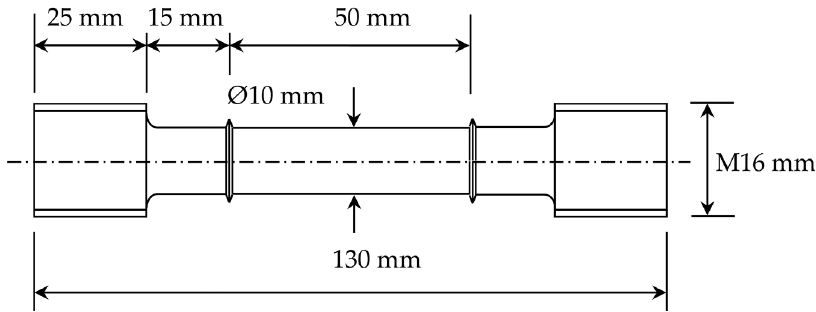
Figure 1: Conventional uniaxial creep test specimen.